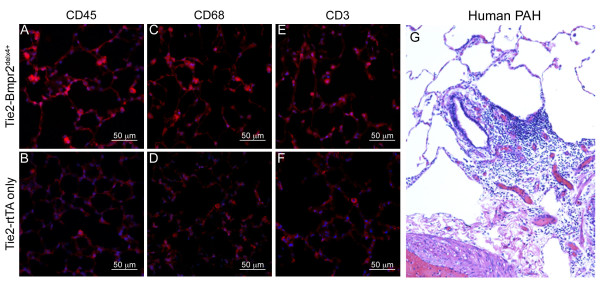
Increased inflammation in Tie2-Bmpr2delx4+ mouse lung compared to Tie2-rtTA only. Blue is DAPI nuclear stain; red corresponds to pan-leukocyte marker CD45 (A,B), macrophage marker CD68 (C,D), or T-cell marker CD3 (E,F). In all cases, there are substantially more inflammatory cells in representative fields from Tie2-Bmpr2delx4+ mouse lung than from control Tie2-rtTA only mouse lung. In contrast to this pattern, end-stage human lung is characterized by massive perivascular inflammation (G) which can be seen in Tie2-Bmpr2delx4+ mice (Additional Figure 1), but is not typical. Human lungs were prepared with Carstairs' Stain.